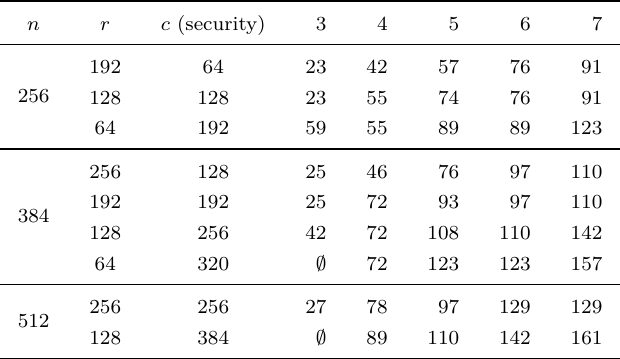
Table 9: The quantity − log ( 𝑝 ) where 𝑝 is an upper bound on the absolute correlation 2 of a linear trail connecting the rate of the input with the rate of the output of various Sparkle instances. The ∅ symbols means that the trails connecting the rate to itself are impossible.